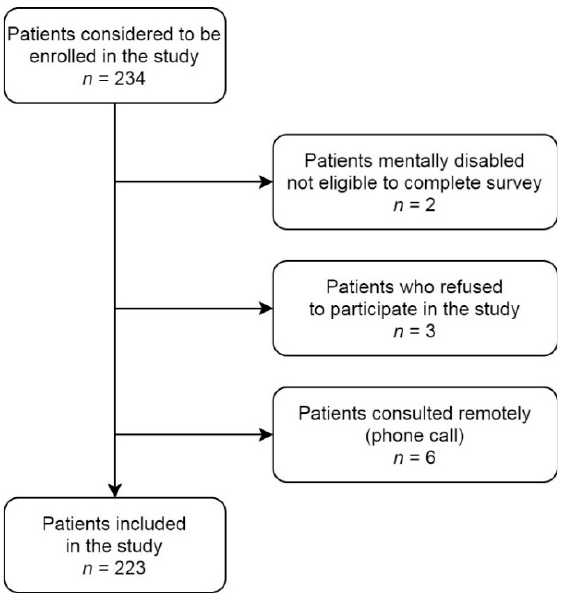
Figure 1. Patients’ disposition participate in the study. A total of 223 patients were finally included in the study. Most of the patients were female (141, 63%). The patients’ median age was 59 years (range 18–90). In the study group, 147 (66%) patients suffered from PAH, while 76 (44%) patients had CTEPH. There